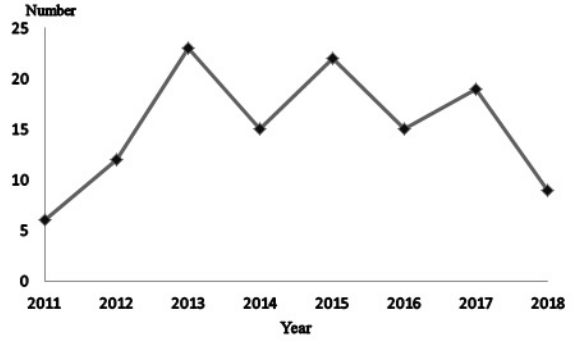
Figure 1. Number of Acute Flaccid Paralysis Cases Reported by Year From 2011 to 2018.